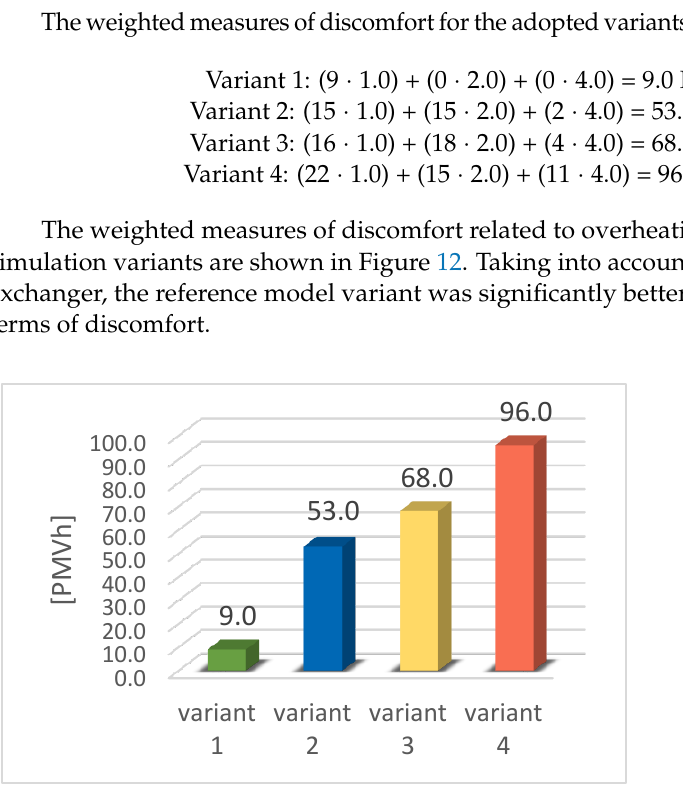
Figure 12. Weighted measure of discomfort related to overheating.